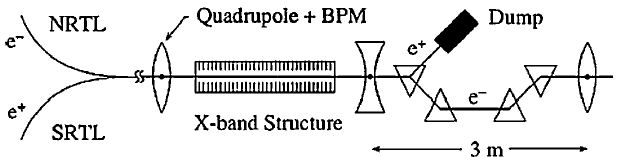
FIG. 1. Schematic representation of ASSET facility at SLAC National Accelerator